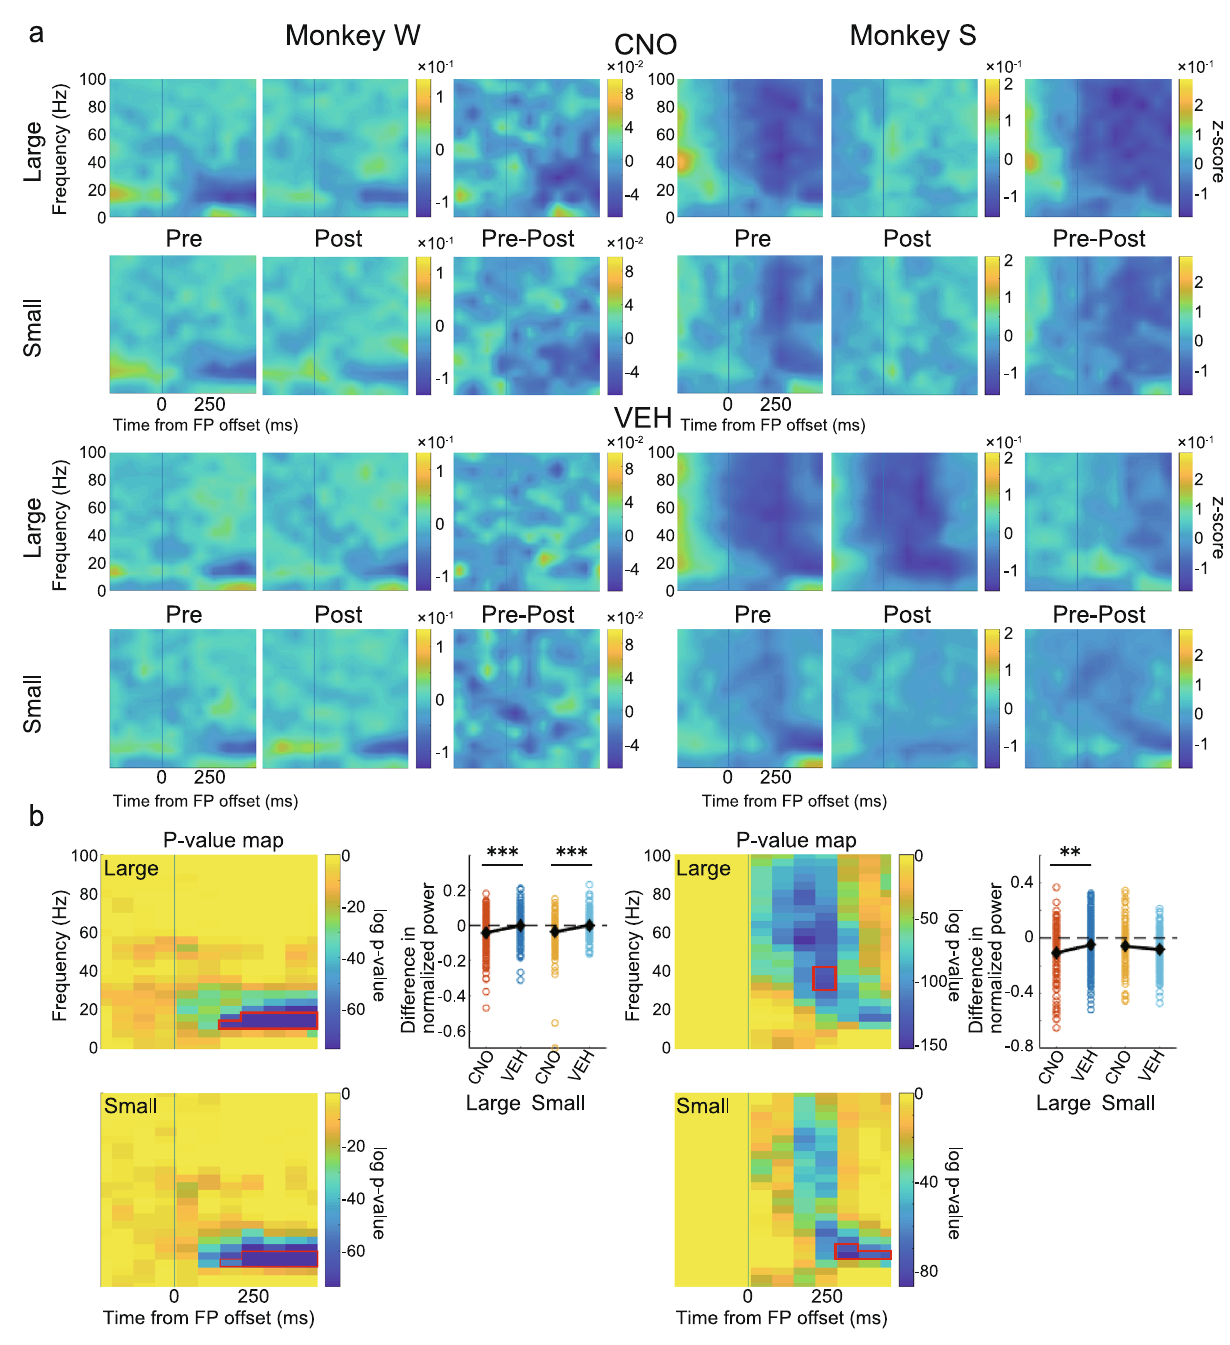
Fig. 7 Effects on spectrogram power in the LPFC after the go signal. a Normalized and averaged spectrograms of LFPs from electrodes in the LPFC for Monkey W (left) and Monkey S (right). Time 0 refers to the FP offset. All other features in this panel are the same as in Fig. 4a. b For each monkey: left: p - value maps made to extract ROIs with a negative component separately for large- and small-reward trials. Color represents log p -value obtained by comparing each time-frequency data point with the corresponding baseline data ( − 500 to 0 ms before cue onset); right: comparison of the effects of CNO/VEH administration. All features in this panel are the same as in Fig. 4b. CNO clozapine N-oxide, VEH vehicle, FP fi xation point, LFP local fi eld potential, LPFC lateral prefrontal cortex, ROI region of